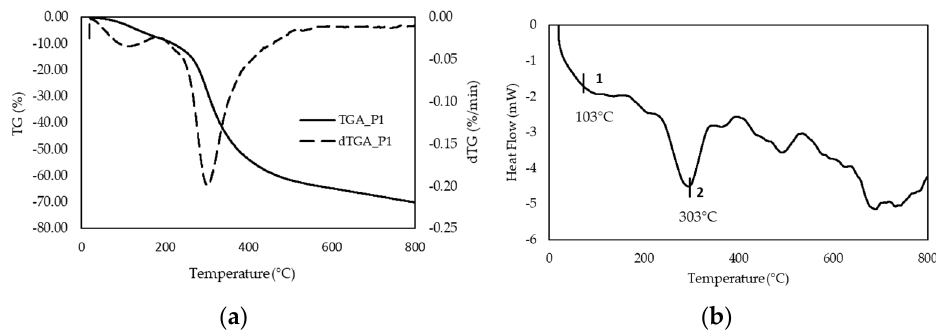
Figure 2. TGA thermogram (solid line, weight loss), and dTGA thermogram (dashed line, differential weight loss) obtained from TG curves ( a ); and DSC thermogram ( b ) of salmon gelatin P1.